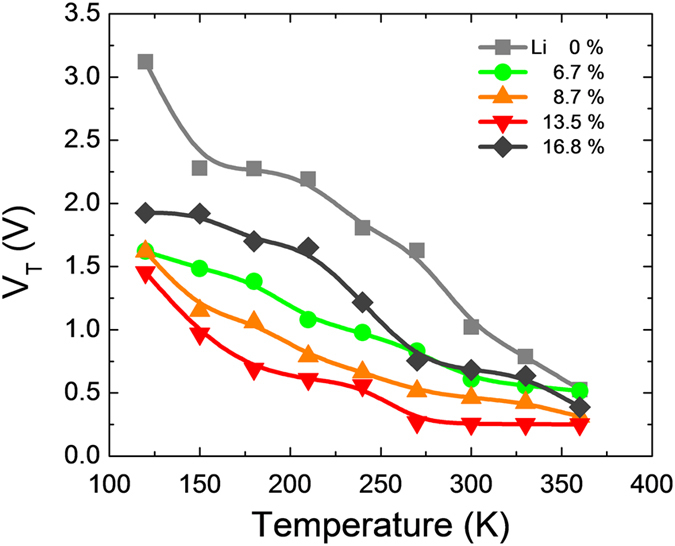
Temperature instability in terms of Vth values for the In2O3 TFTs with different Li loadings.